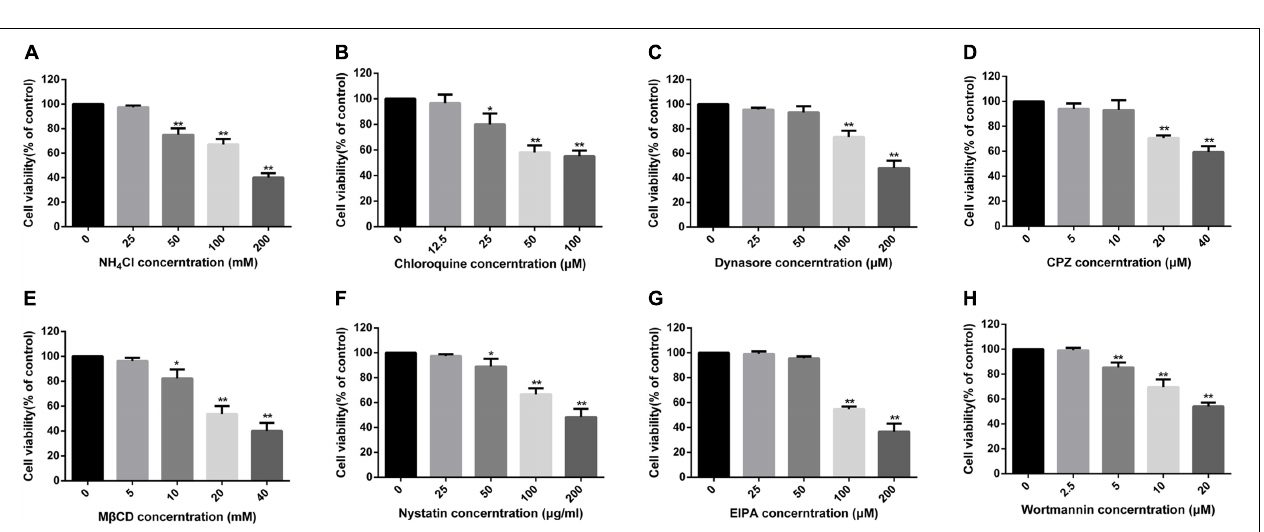
FIGURE 1 | Kinetics of PPRV entry and replication in EECs. (A) CLSM analysis of actin filaments (red), viral particles (green) and cell nuclei (blue) in PPRV-infected EECs at the indicated time points post-infection. 3D images are shown in the lower panels. (B) One-step growth curve of PPRV in EECs, as determined by a TCID 50 assay. (C,D) Western blot analysis of N protein expression to indicate virus replication in PPRV-infected EECs at the indicated time points post-infection. Representative blots and densitometry analysis of the data are presented in (C,D) , respectively. β -actin was used as an internal control. The bars indicate the mean ± SD from three independent experiments. SD, standard deviation.